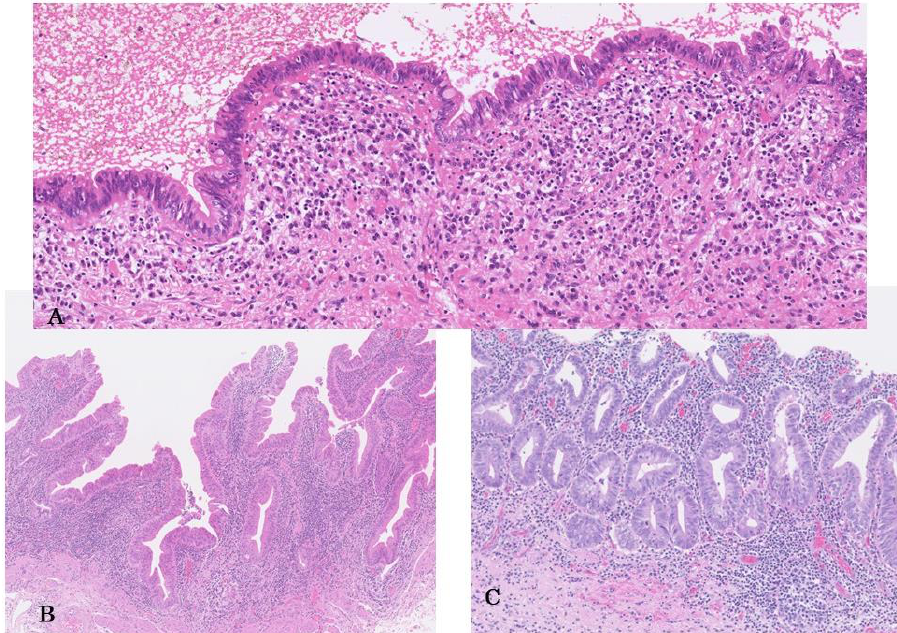
Figure 1. High-grade biliary intraepithelial neoplasm (high-grade BilIN); ( A ) Flat type. Lining epithelia of the extrahepatic bile duct show pseudostratified and hyperchromatic and swollen nuclei. Nuclear polarity is variably lost. × 300. HE staining. ( B ) Micropapillary type. Micro- and short- papillary structures are lined by neoplastic atypical epithelia. Gallbladder. × 80. HE staining. ( C ) Propria forming type. Atypical glands with mucosa propria formation, appearing as so-called intramucosal carcinoma of the stomach. Extrahepatic bile duct. × 100. HE